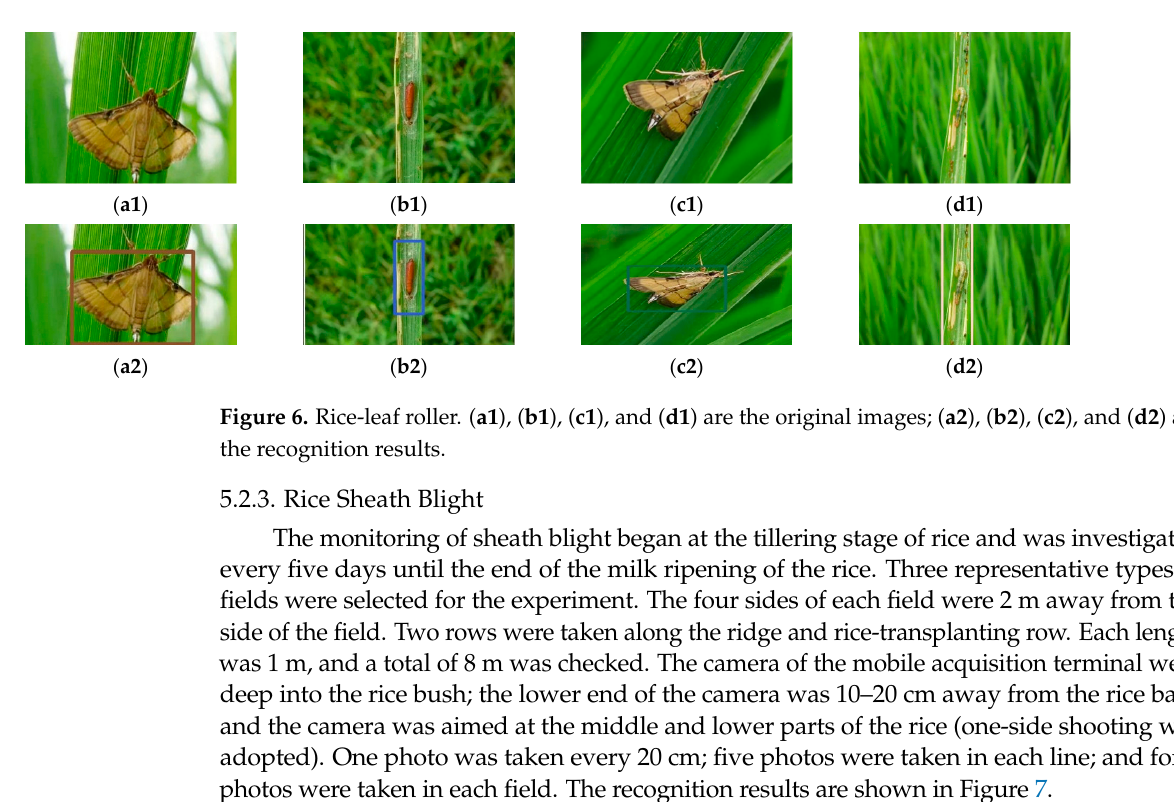
( d2 ) Figure 8. Wheat spider. ( a1 ), ( b1 ), ( c1 ), and ( d1 ) are the original images; ( a2 ), ( b2 ), ( c2 ), and ( d2 ) are the recognition results. 5.2.5. Wheat Aphid The investigation was to be conducted once every seven days from the green jointing stage to the milk ripening stage of wheat. When the number of aphids rose sharply and